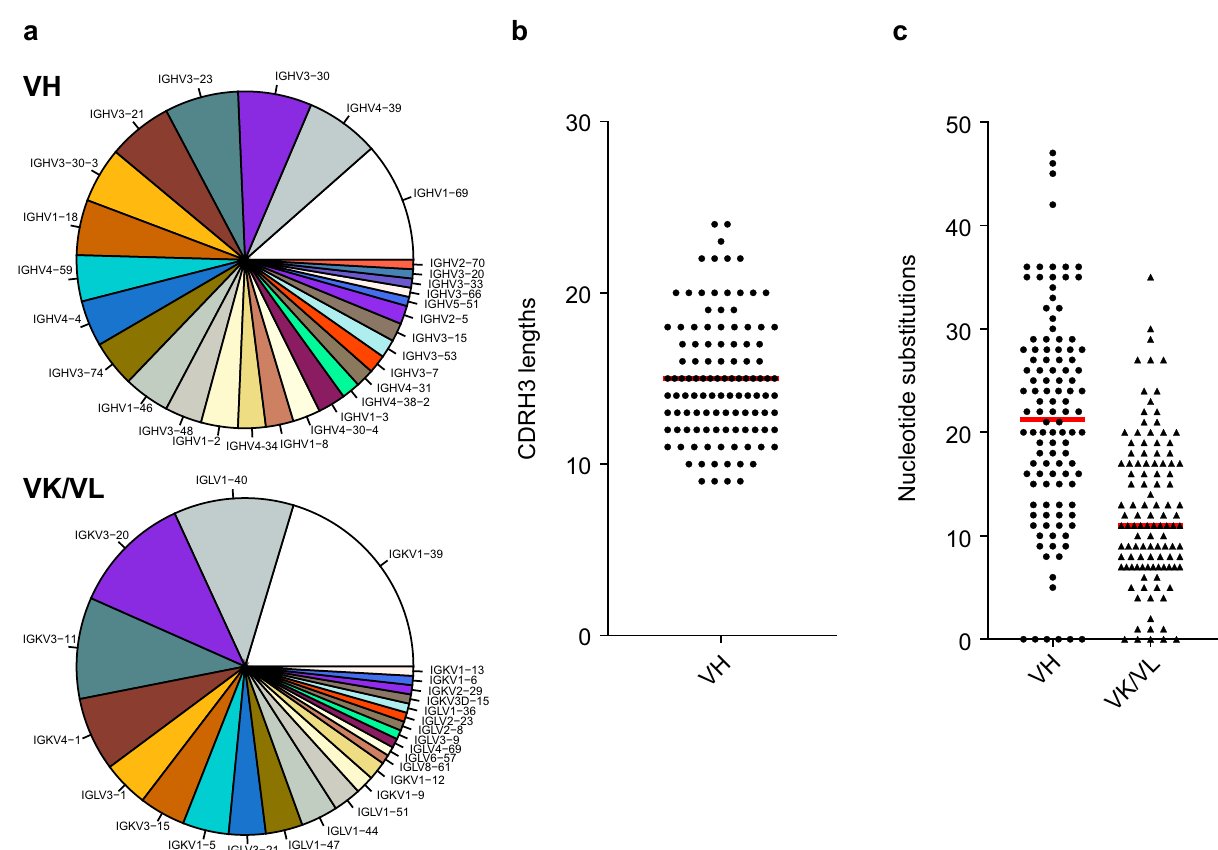
Fig. 1 CDRH3 lengths and somatic hypermutations (SHM) of hMPV F-speci fi c mAbs. a Germline frequency of VH and VK/VL. b CDRH3 lengths. c Nucleotide substitutions of VH (excluding CDRH3), and VK/VL. Red bars indicate the median. The analysis was based on the Kabat delineation system 75 . Source data are provided as a Source Data fi